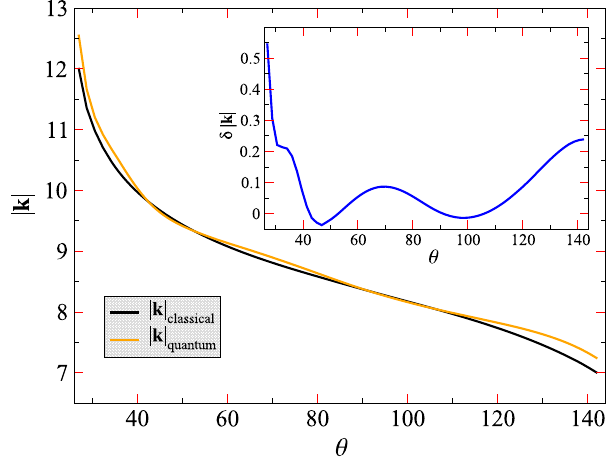
FIG. 22. The behavior of the classical j k and quantum j k cl j qu j ordering wave vectors as a function of θ ¼ arctan ð J 2 =J 1 Þ . Inset: − j k Deviation j δ k j ¼ j k of the ordering wave vector k from qu j cl j its classical value as a function of θ